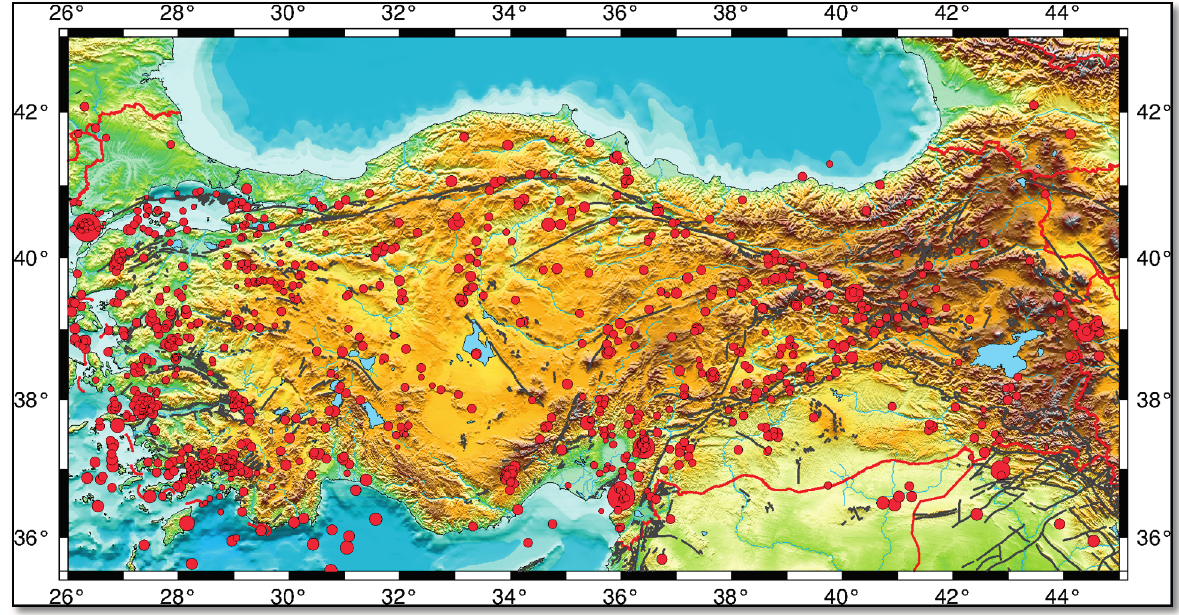
Figure 1. A comparison of different types of disasters in Turkey (after [5]).